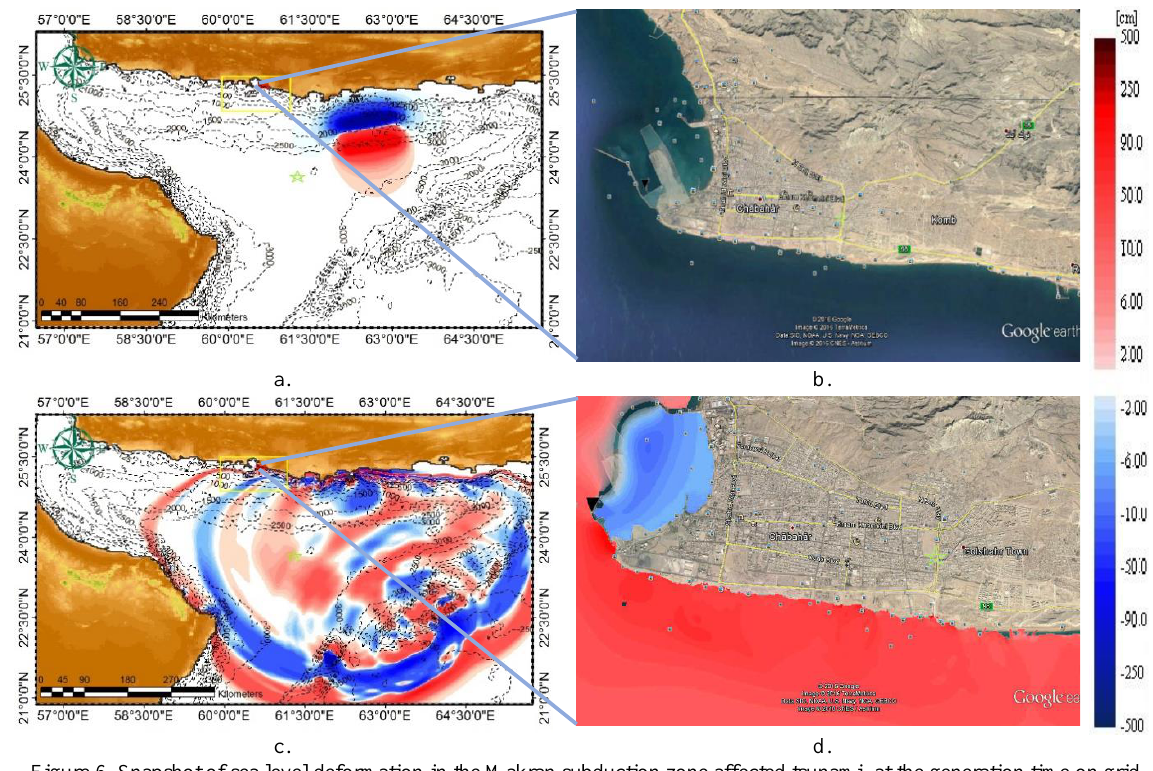
Figure 6. Snapshot of sea level deformation in the Makran subduction zone affected tsunami, at the generation time on grid layer A (a), Chabahar port at the tsunami generation time on grid layer C (b), propagation of the tsunami waves at 35 minutes after the generation on grid layer A (c), inundation tsunami at 35 minutes after the generation on grid layer C (d).